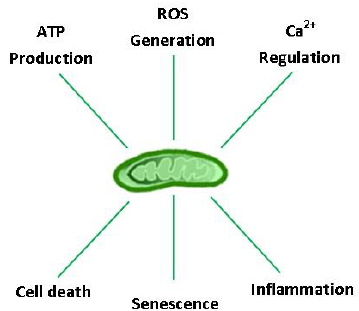
Figure 1. Major eukaryotic cell functions regulated by mitochondria. ATP: adenosine triphosphate; + : calcium ROS: reactive oxygen species; Ca 2+ : calcium ion. ROS: reactive oxygen species; Ca 2